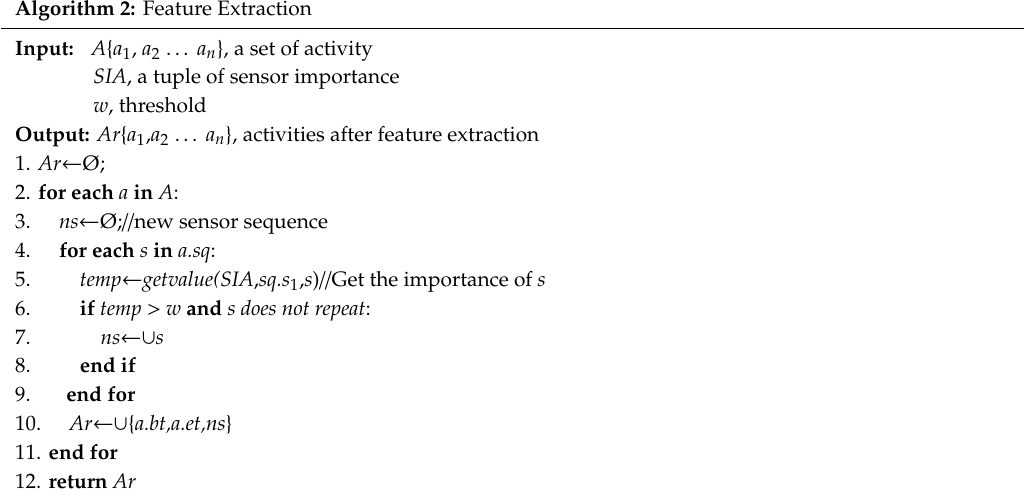
Algorithm 2: Feature